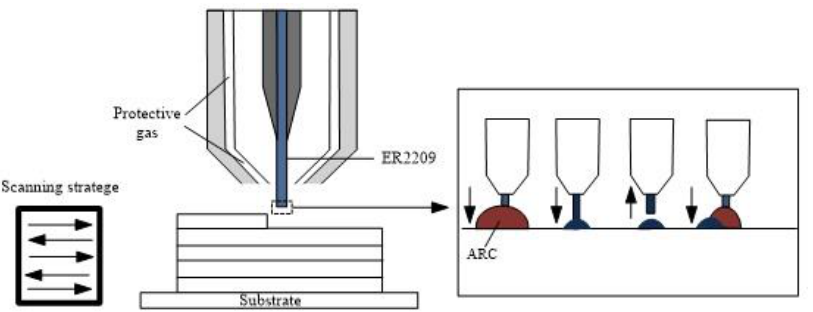
Figure 1. Schematic diagram of multi-layer single-pass CMT-WAAM.